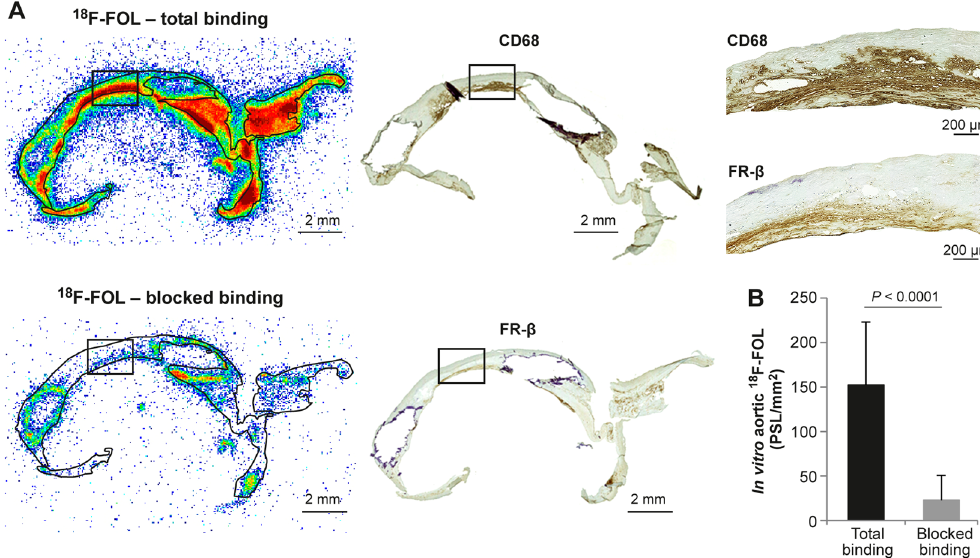
Figure 2. In vitro binding of 18 F-FOL in human carotid artery samples. 18 F-FOL autoradiography and immunohistochemistry of adjacent carotid endarterectomy samples from patients with recent ischemic symptoms ( n = 5). ( A ) Left: Representative autoradiographs of total and folate glucosamine-blocked binding of 18 F-FOL on 7 µ m adjacent cryosections. Middle: CD68 (macrophages) and folate receptor β (FR- β ) immunohistochemical staining of the same cryosections as in figure A. Note that the other section has ruptured during the CD68 staining process. Top right: high-power views of CD68 and FR- β immunohistochemical staining in the area within the black rectangle on the autoradiographs. CD68 and FR- β positive cells appear as a brown color. ( B ) In vitro autoradiography-based quantification of 18 F-FOL binding in tissue cryosections verifies the signal’s specificity to folate receptors (paired t- test). Error bars denote standard deviation. PSL/ mm 2 = photostimulated luminescence per mm 2 .